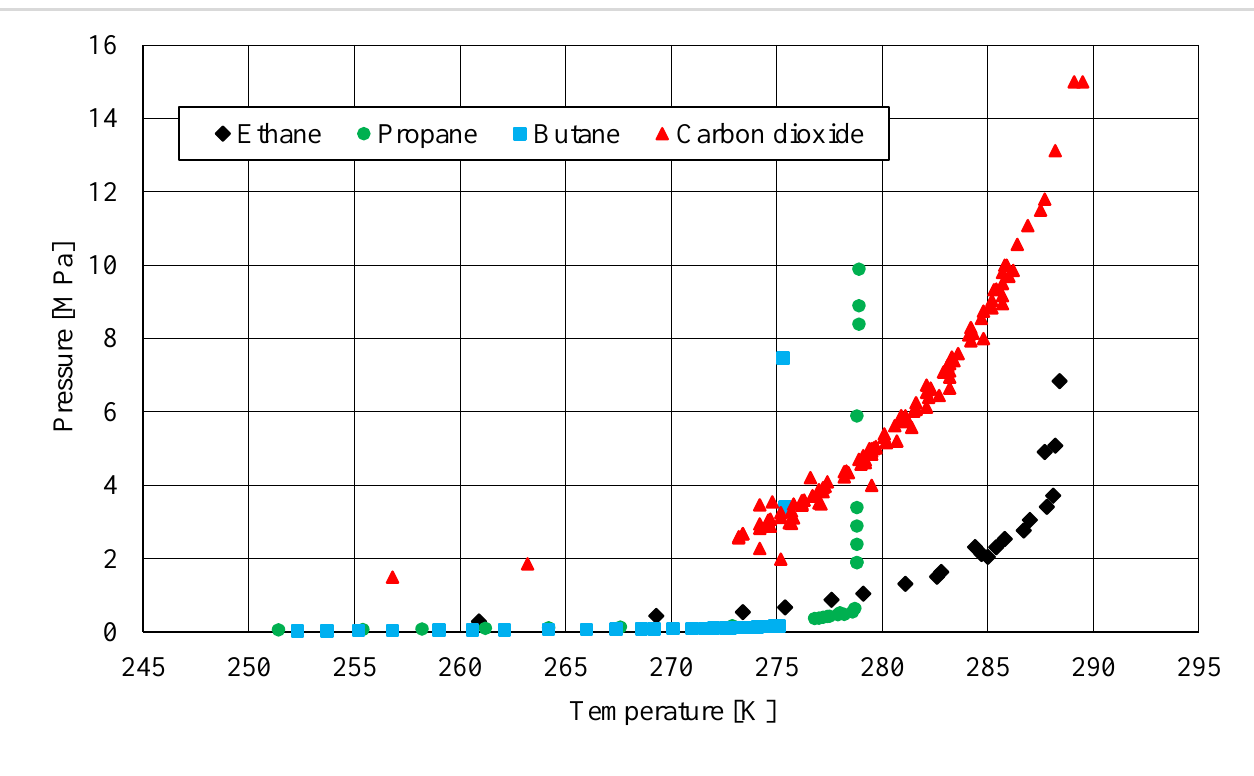
Figure 4 resumes the phase equilibrium boundary conditions for hydrate made with exclusively those complementary gases.